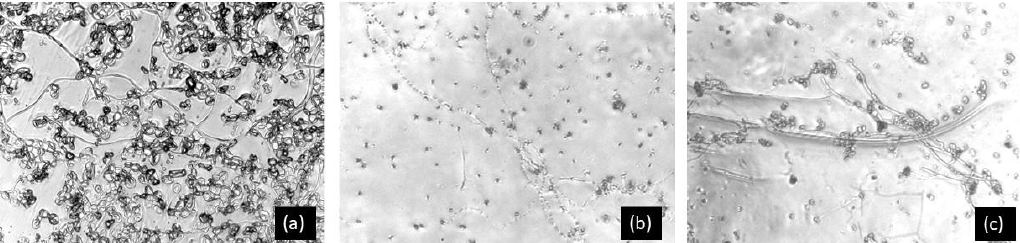
Figure 2. C. sitophila in colophony not treated with biocides ( a ) (400×) and treated with ( b ) Metatin N (spread, 100×) and ( c ) Preventol ® ON (spread, 400×) after five days of incubation.